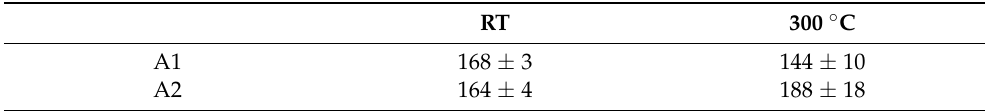
Table 2. Average microhardness (HV 1 ) values and standard deviations of A1 and A2 alloys at RT and 300 ◦ C.